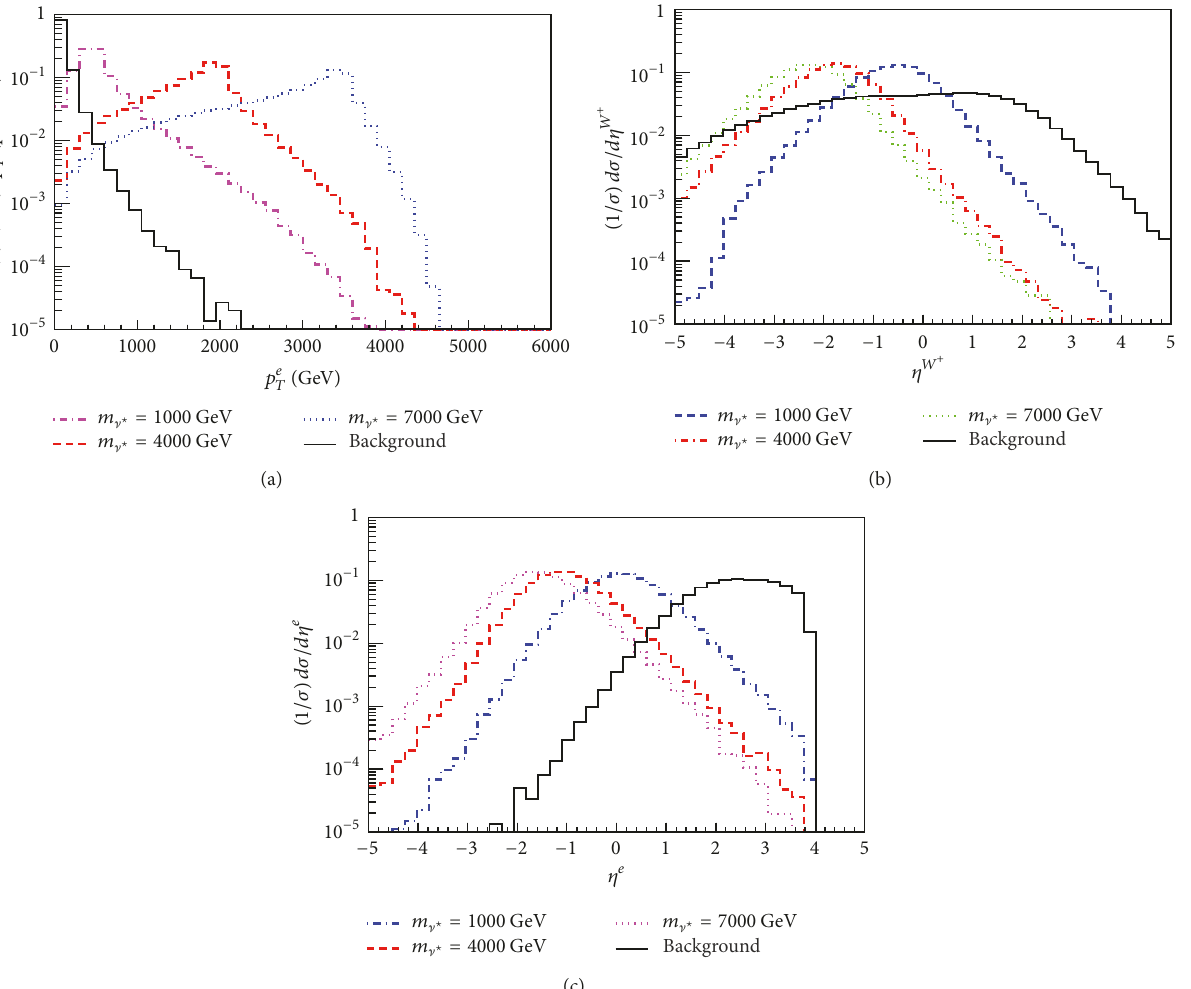
Figure 6: The normalized transverse momentum distributions of the final state electrons (a), the normalized pseudorapidity distributions of the final state 𝑊 + bosons (b), and the normalized pseudorapidity distributions of the final state electrons (c) for 𝑓 = 𝑓 󸀠 = 1 and Λ = 𝑚 ] ⋆ at the ILC ⊗ FCC collider.